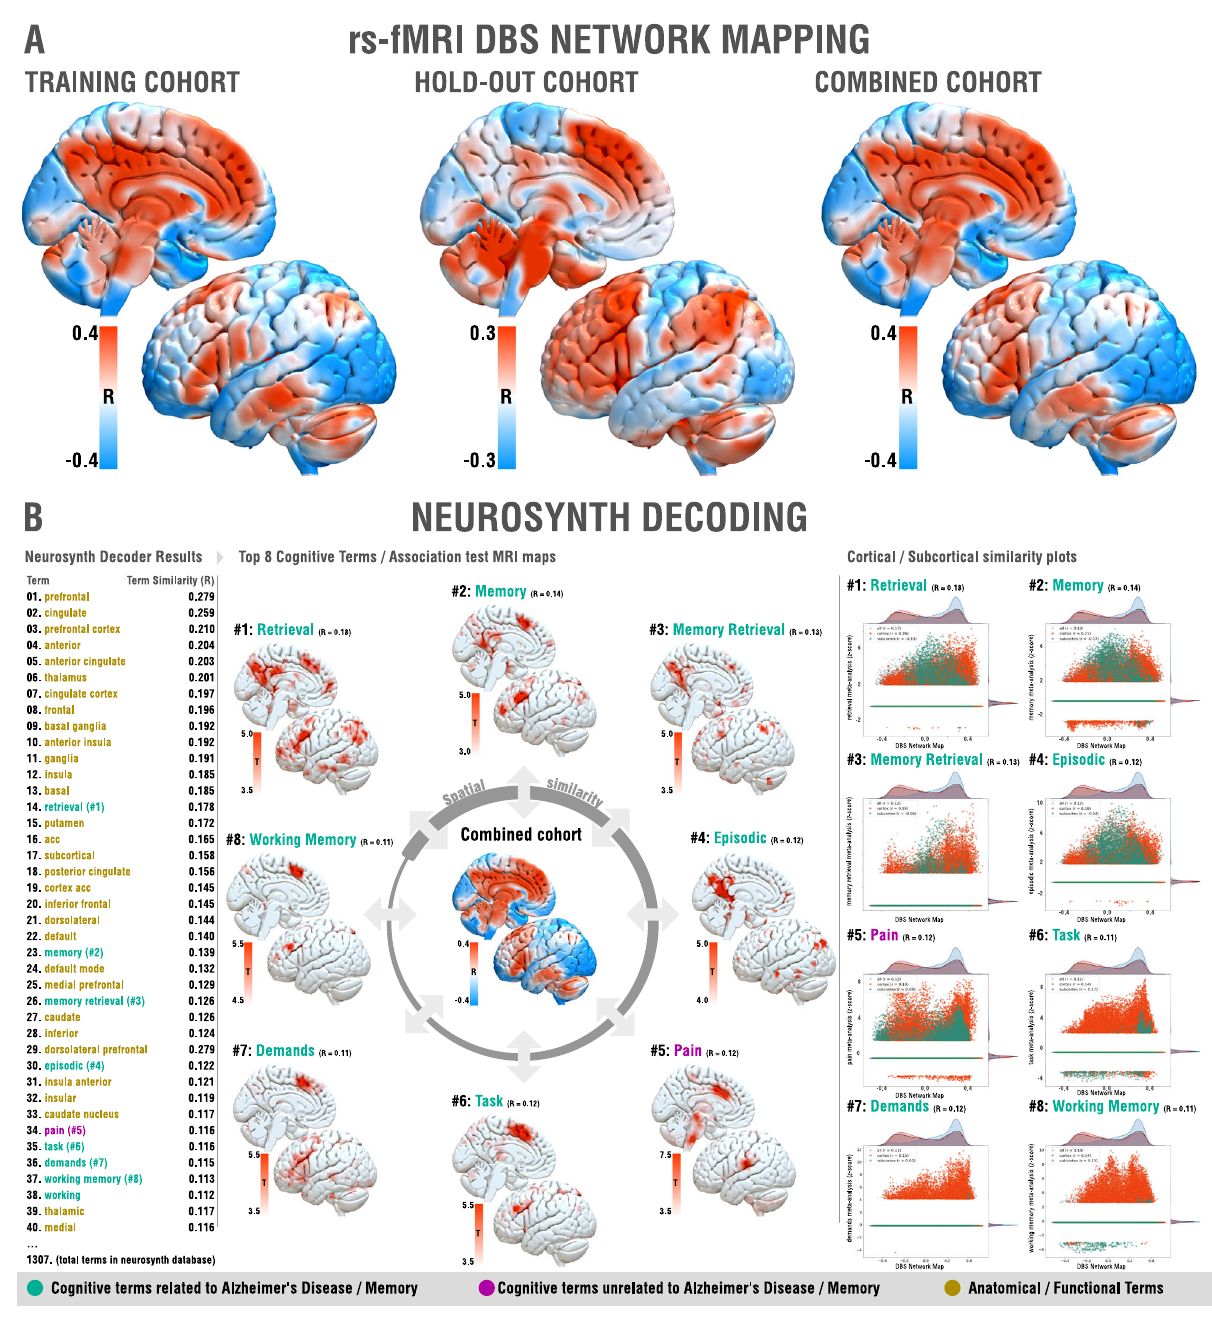
Fig. 4 | Functional network results. A Functional networks associated with opti- mal improvements across training (left), hold-out (middle) and combined (right) cohorts. Brain regions are color-coded by correlations between degree of func- tional connectivity with DBS electrodes and clinical improvements across the cohorts. Since results were highly symmetric, only the left hemisphere is shown.